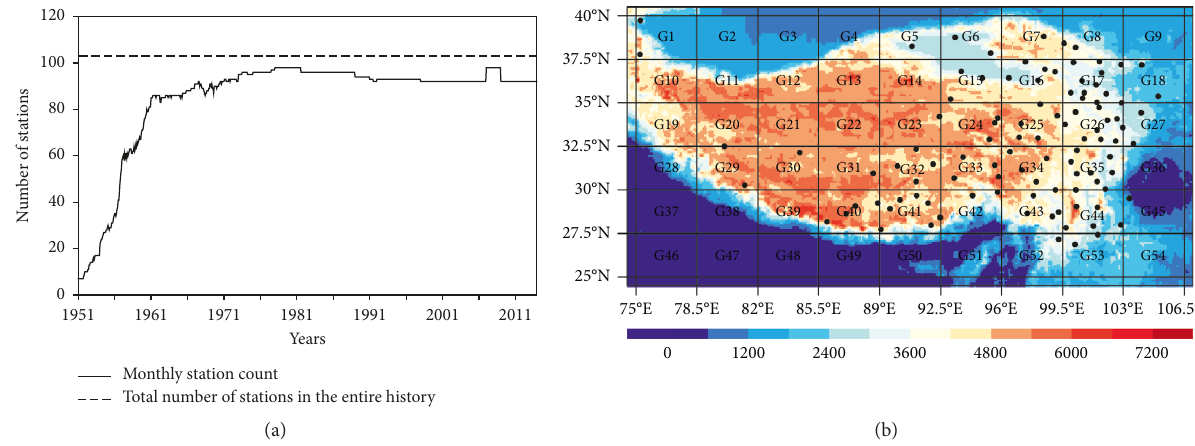
Figure 1: (a) Evolution of the number of stations with temperature records; (b) spatial distribution of the meteorological